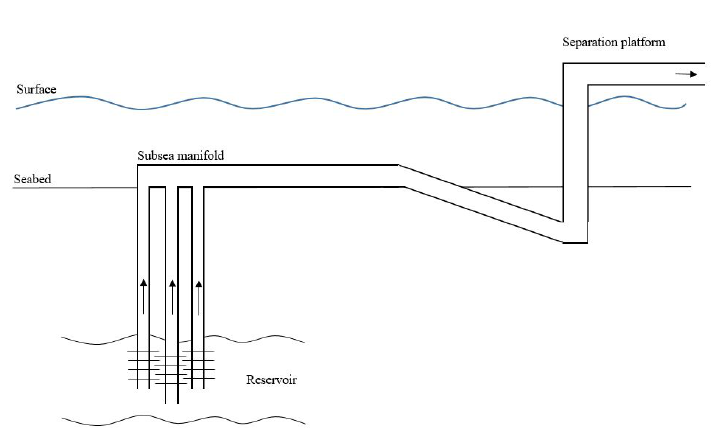
Figure 1. Subsea manifold and transportation pipelines to separation